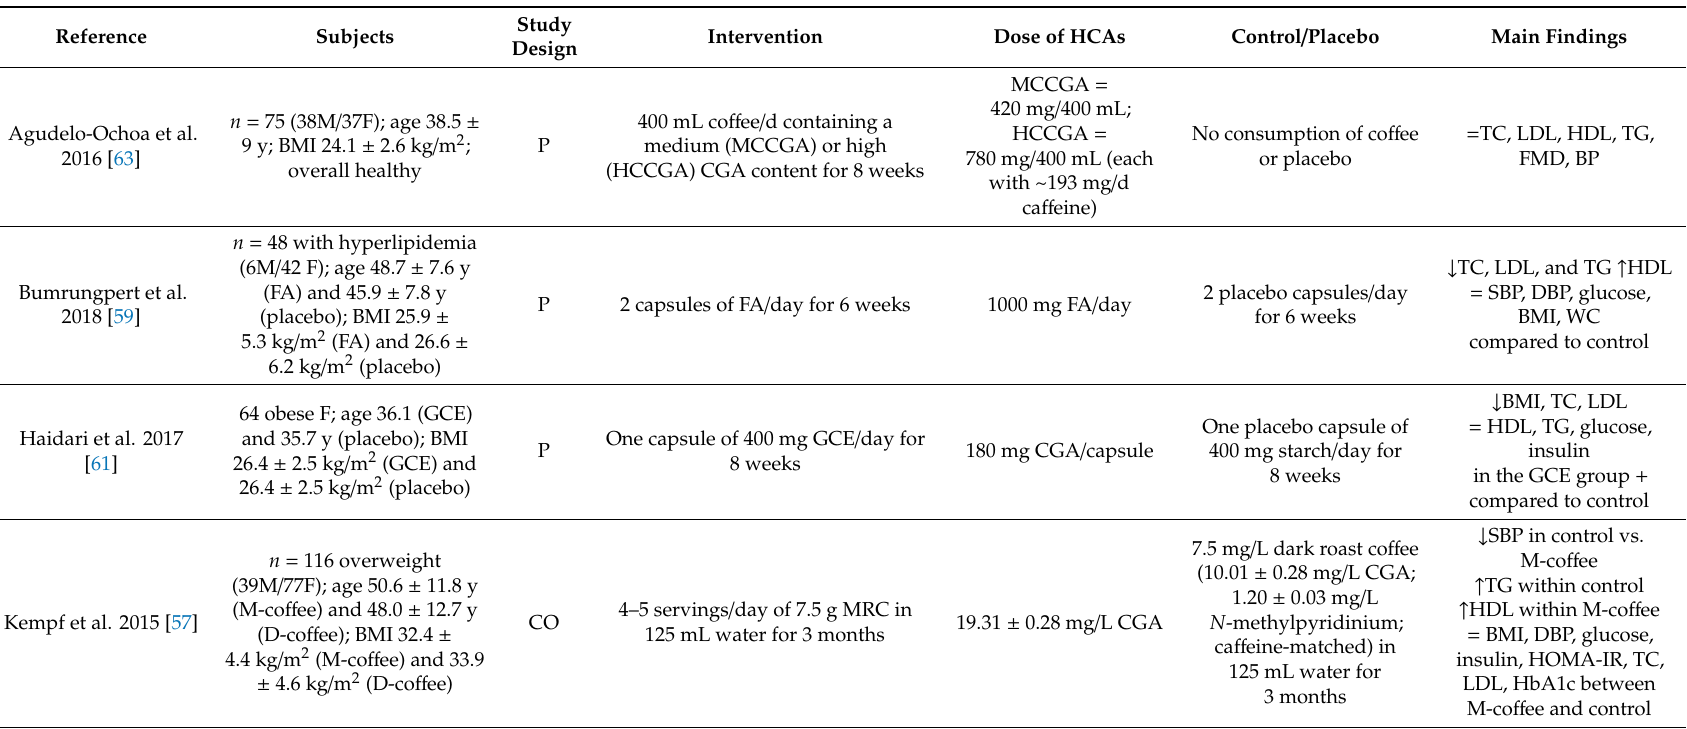
Table 2. Characteristics of the considered chronic intervention studies investigating the e ff ect of HCA-rich foods on cardiometabolic